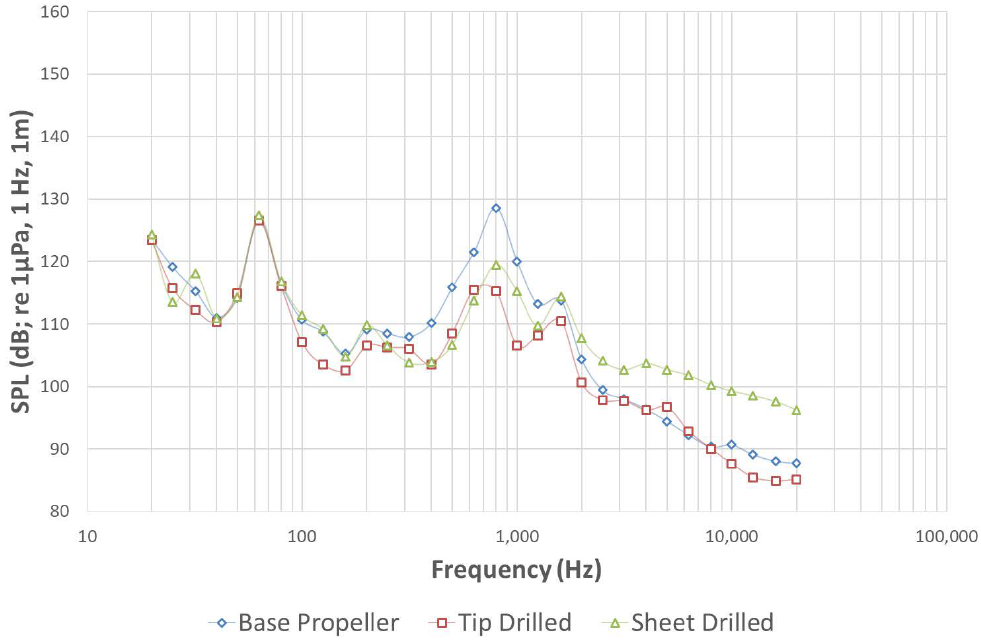
Figure 5. Comparative sound pressure levels of three model propellers tested for J = 0.50 and cavitation condition. Reproduced from [13] with permission from Newcastle